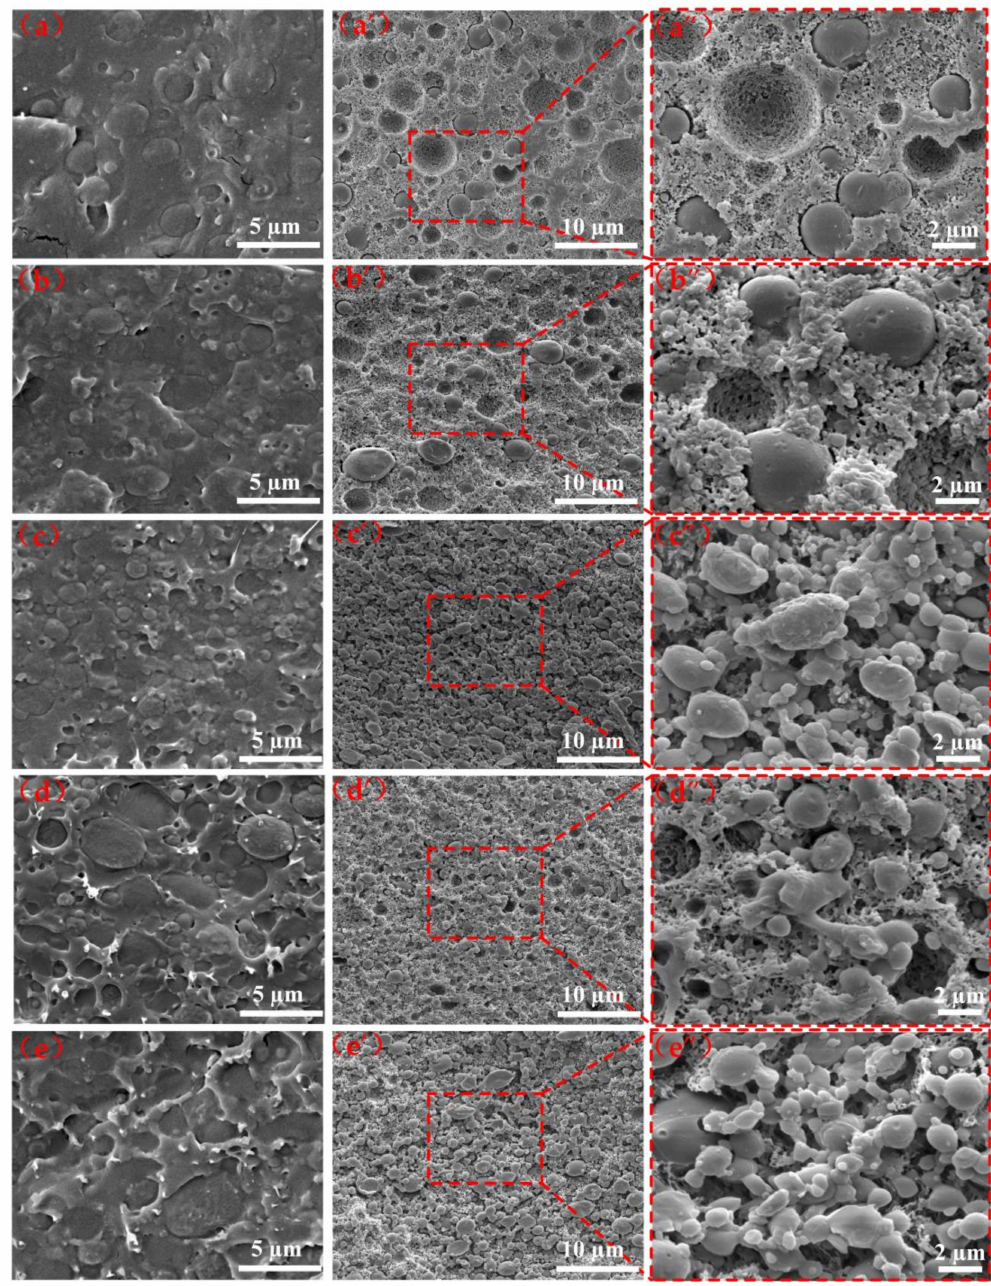
Figure 5. SEM images of cryofracture and PLA amorphous were etched cryofracture samples: ( a – e ) cryofracture surfaces; ( a’ – e’,a” – e” ) etcyed cryofracture surfaces: ( a – a” ) PLA/PBS 70/30; ( b – b” ) PLA/PBS/EGMA 70/30/5; ( c – c” ) PLA/PBS/EGMA 70/30/10; ( d – d” ) PLA/PBS/EGMA